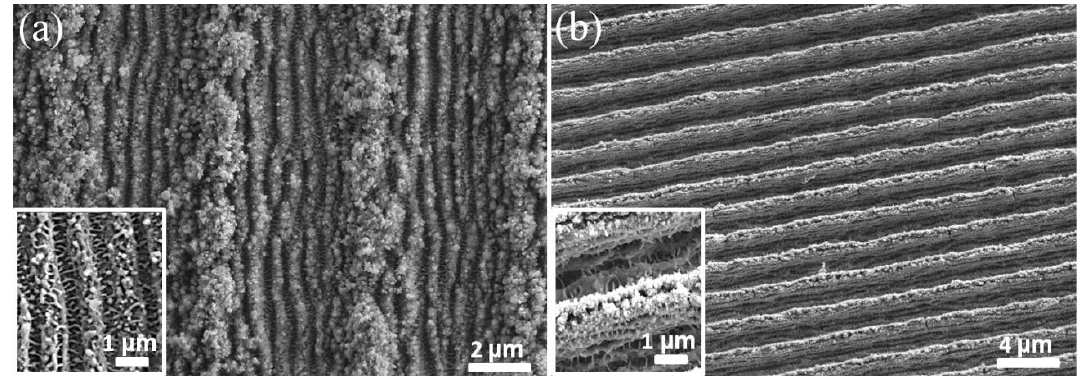
Figure 5. Line-like periodic structures fabricated by Direct Laser Interference Patterning using a laser fluence of 1.42 J/cm² and 99% of pulse-to-pulse overlap on ( a ) ferritic steel (with an spatial period of 5.2 µm) and ( b ) on Ti6Al4V (with and spatial period of Λ = 2.9 µm). The insets show the appearance of HSFL. LSFL can be also observed, mainly at the positions corresponding to the interference maxima.